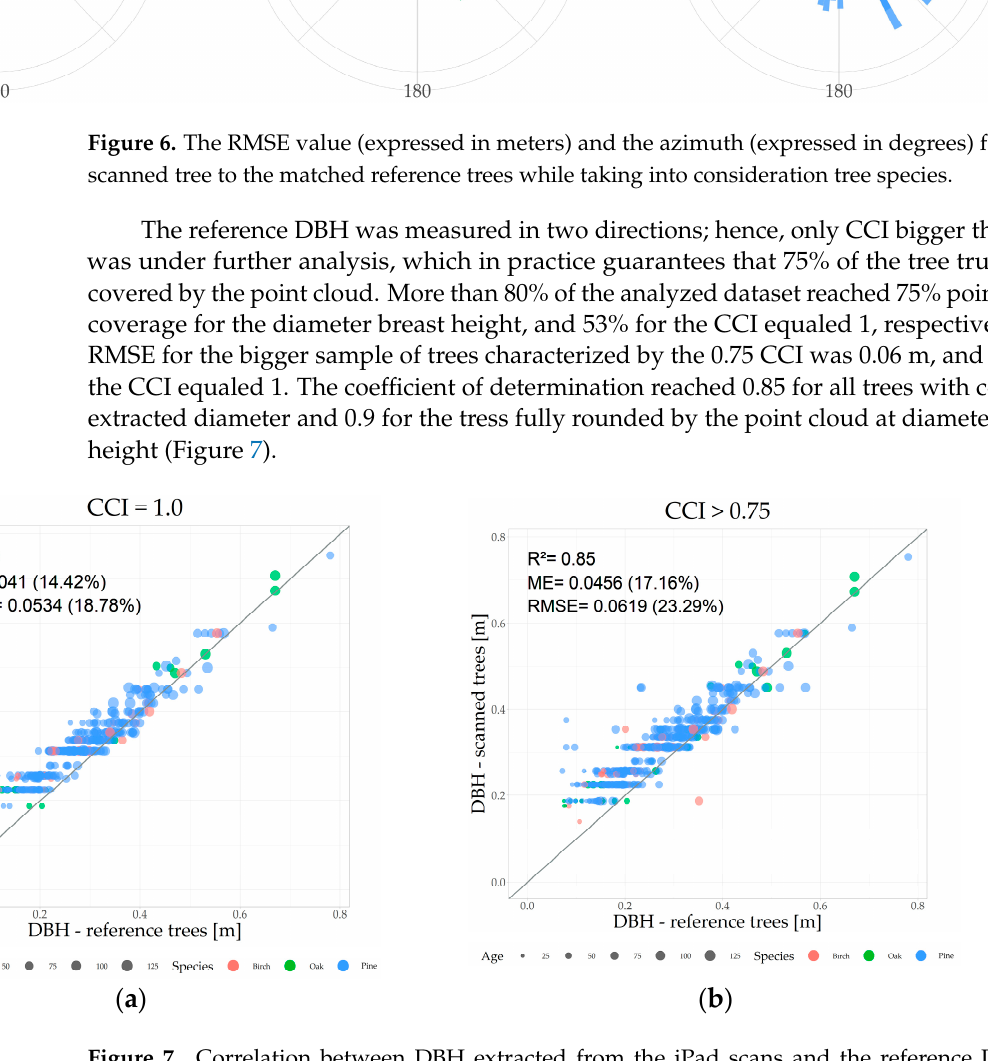
the main tree species and trees age: ( a ) Circumferential Completeness Index equal to 1; ( b ) Circumferential Completeness Index equal to 0.75.